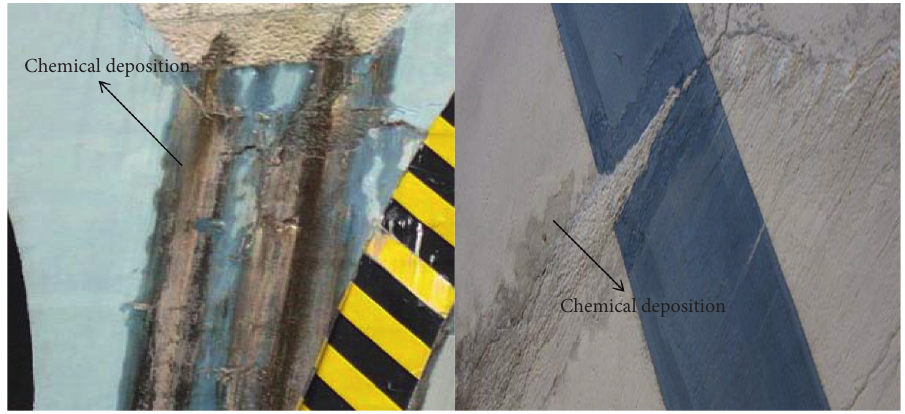
Figure 1: Chemical deposition of seepage